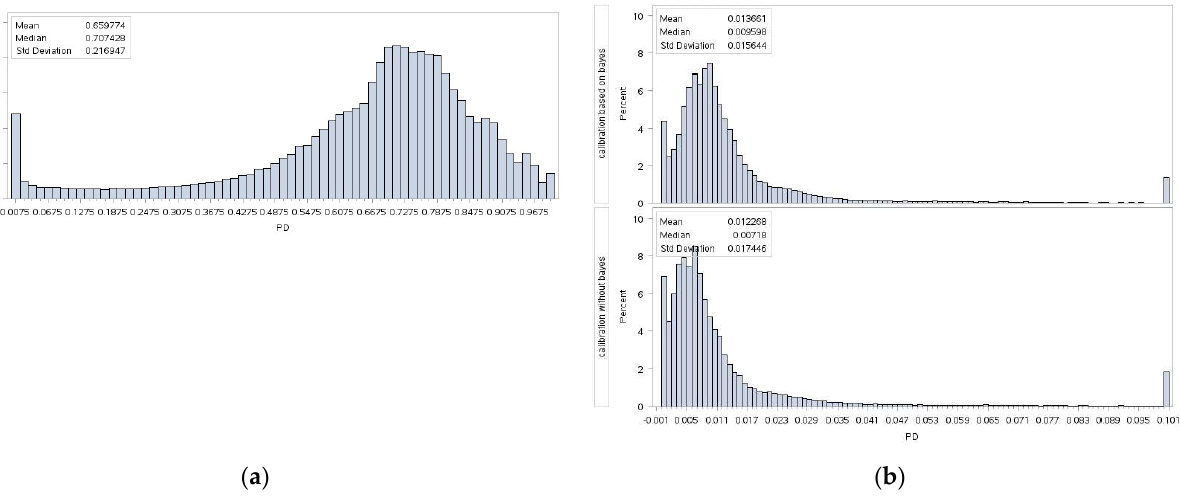
Figure 6. PD distribution: ( a ) Raw PD; ( b ) PD calibrated with and without the Bayesian approach. Source: own elaboration using SAS Enterprise